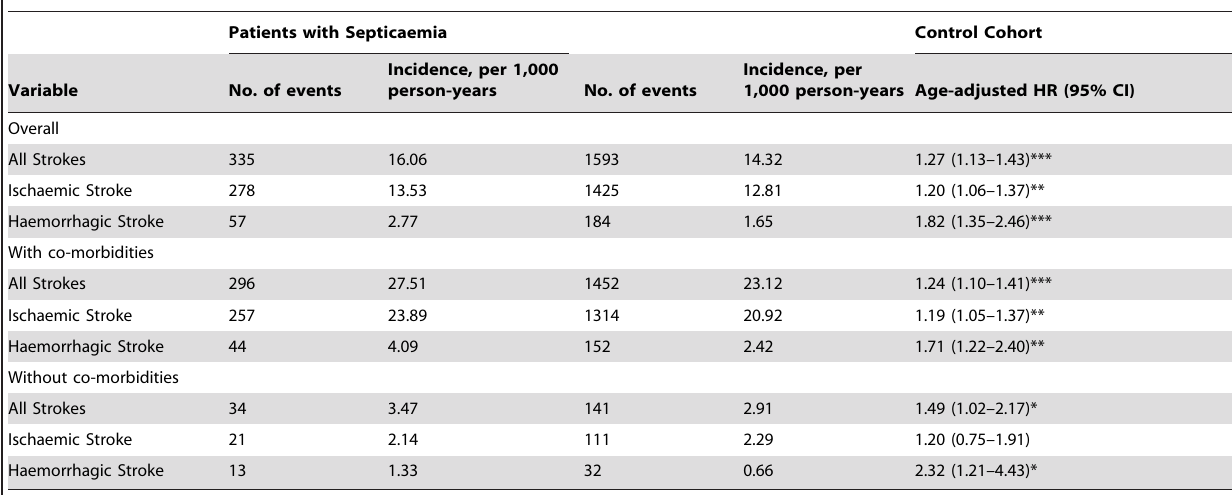
Table 2. Hazard ratios for development of stroke associated with septicaemia.